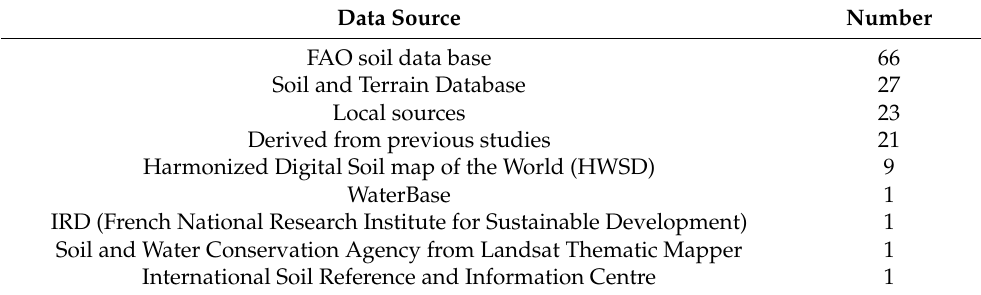
Table A2. Soil data sources.